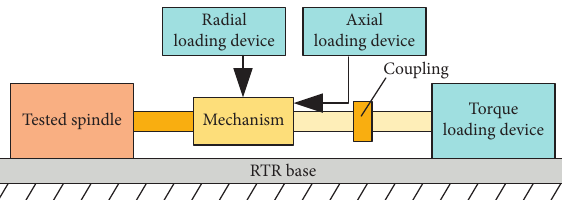
Figure 1: The schematic design of the RTR.